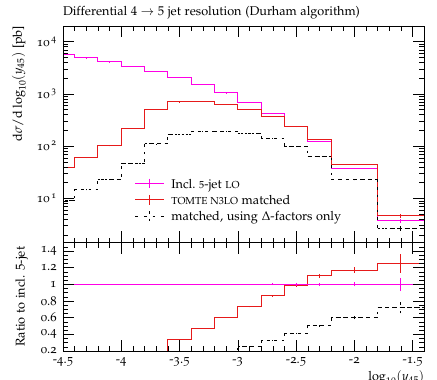
(a) Separation of the 4th and 5th hardest jets, as proxy for (inclusive) observables depending on at least five partons.